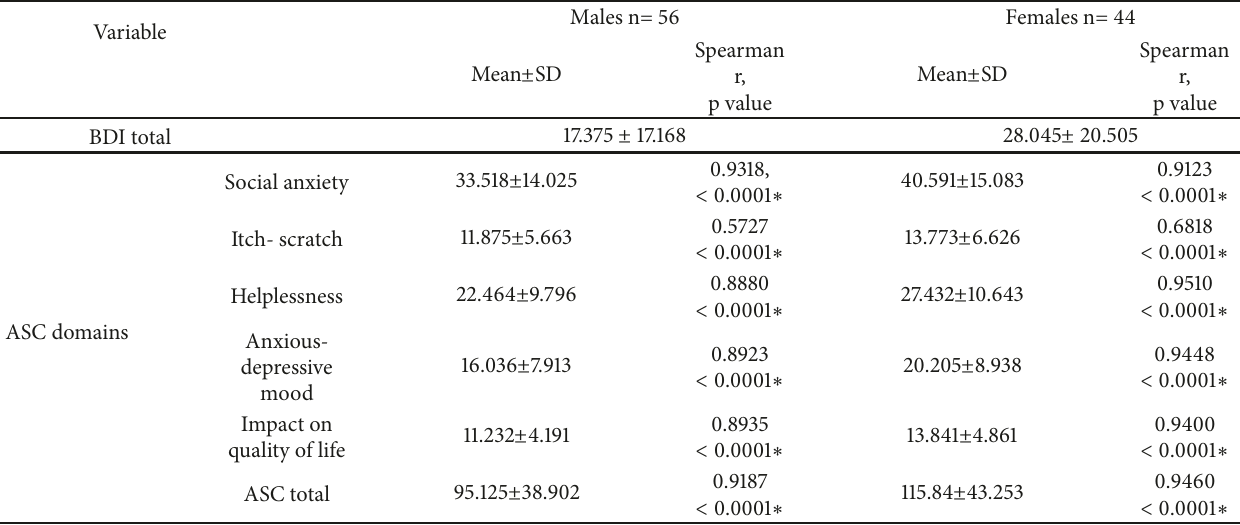
Table 6: Association of depression with coping in both genders.